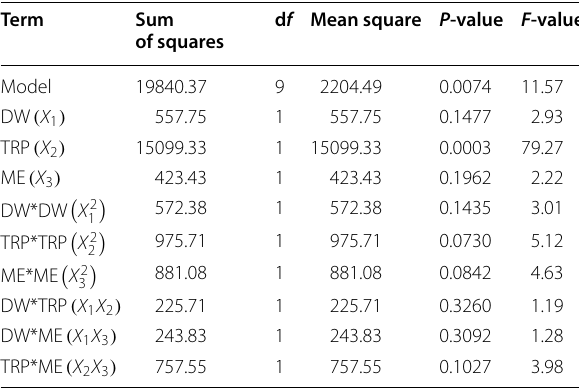
Table 3 Analysis of variance (ANOVA) for response surface quadratic